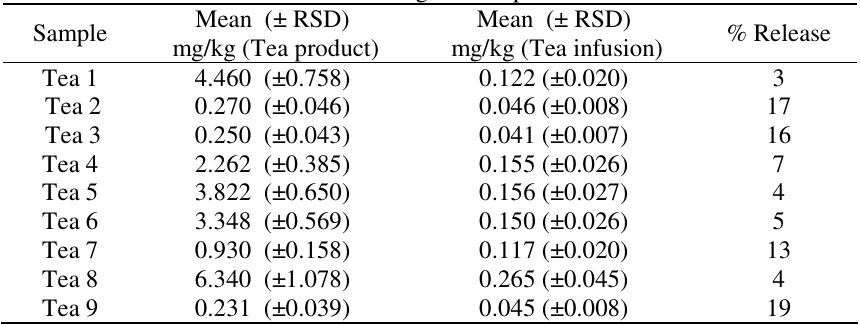
Table 4. Concentration of lead in green tea products and their